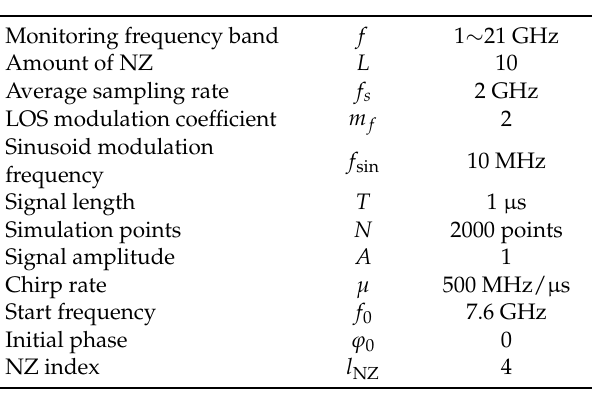
Table 1. The simulation